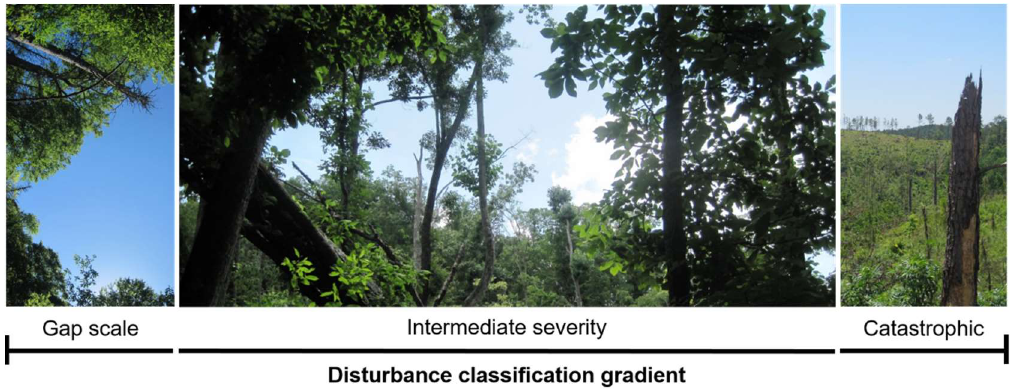
Figure 1. Forest disturbance classification gradient based on spatial extent, magnitude, and frequency of discrete disturbance events (adapted from Hart [9]). Basal area removed increases from left to right.